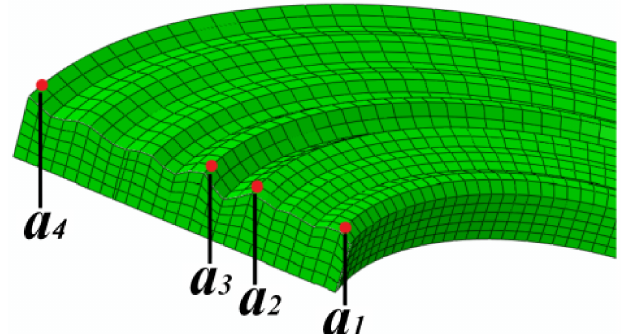
Figure 5. Reference node selection.